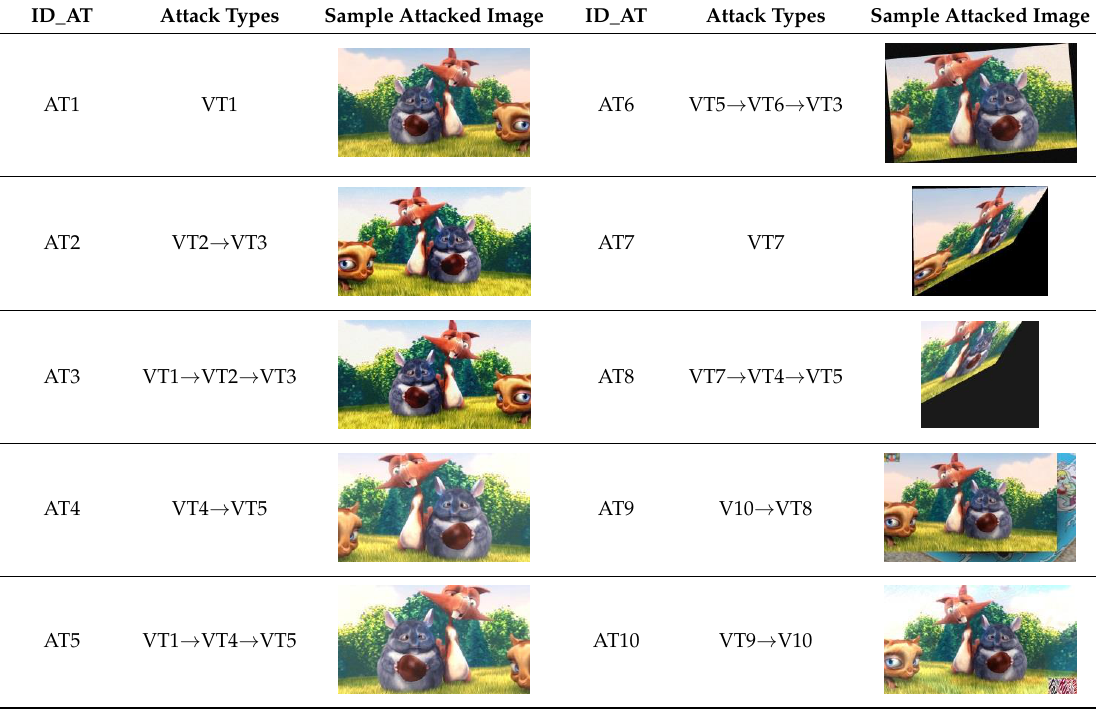
Table 20. The experimental parameters.